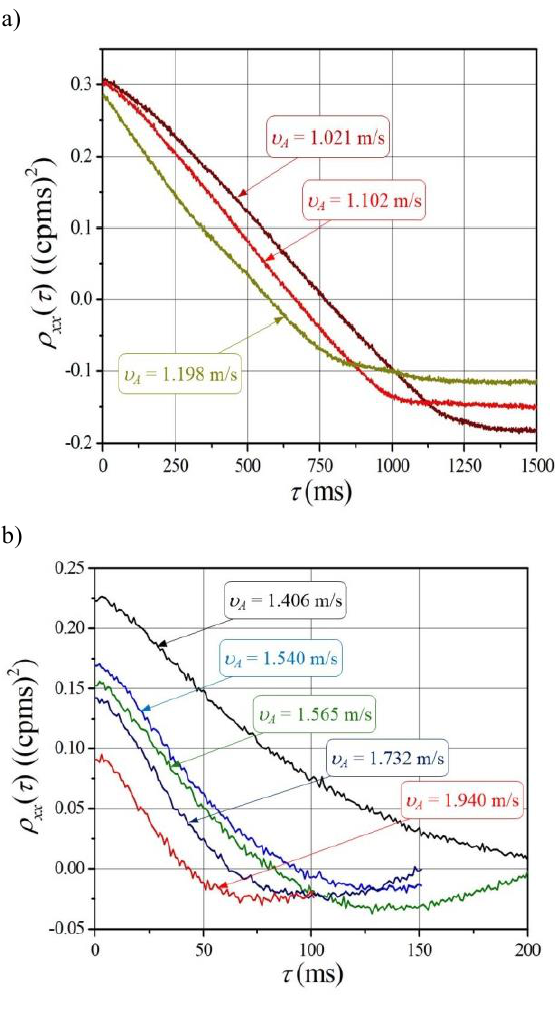
Fig. 4. Changing the ACF shape for a) slug flows ; b) plug flows.